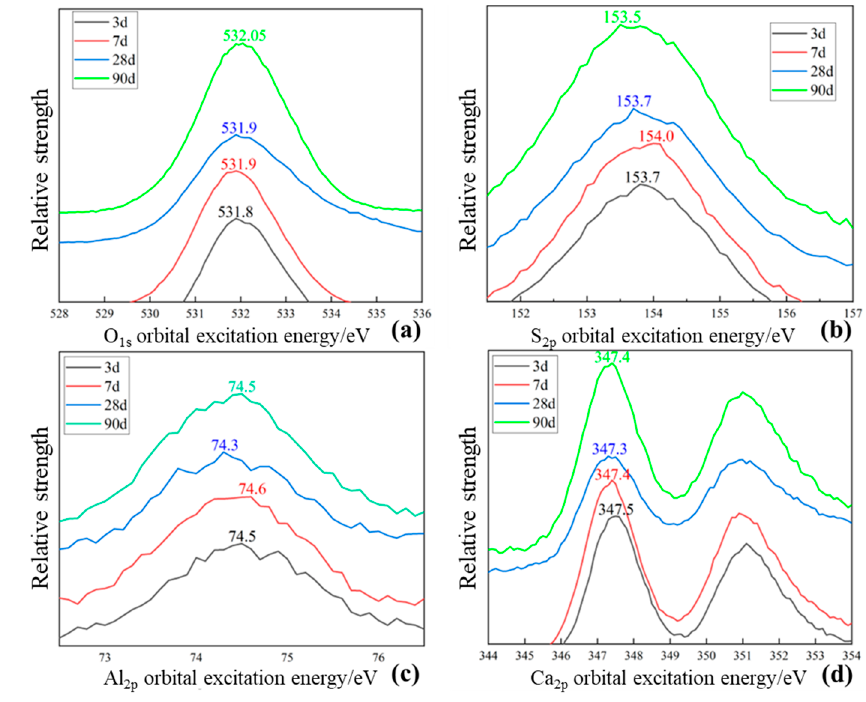
Figure 7. XPS spectra of main elements at different ages.